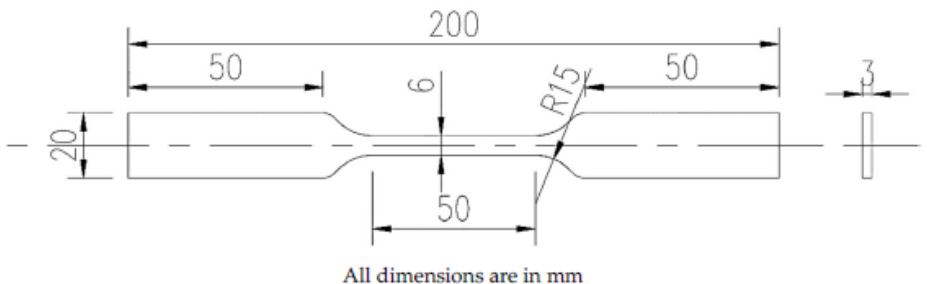
Figure 5. Tensile specimen dimensions.